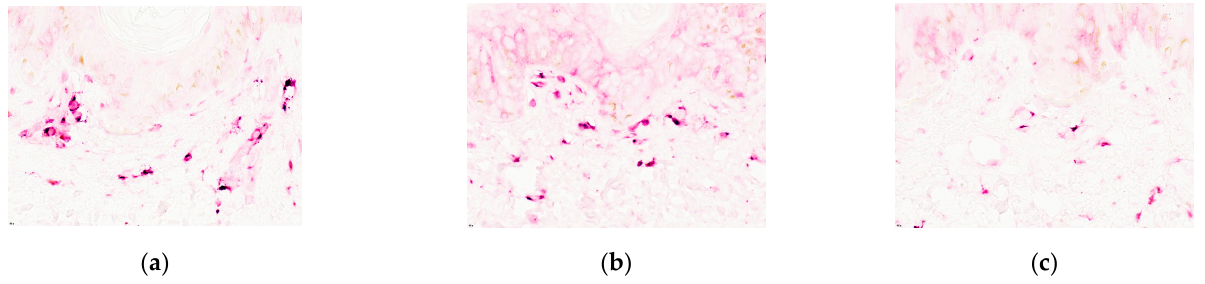
Figure 10. MMP-1 immunostaining in the papillary dermis of the batches irradiated with infrared on D6 ( a ), irradiated with infrared, and pre-treated with the Melissa officinalis phytocomplex at 0.05% ( b ) or 0.1% w/v ( c ) on D6.